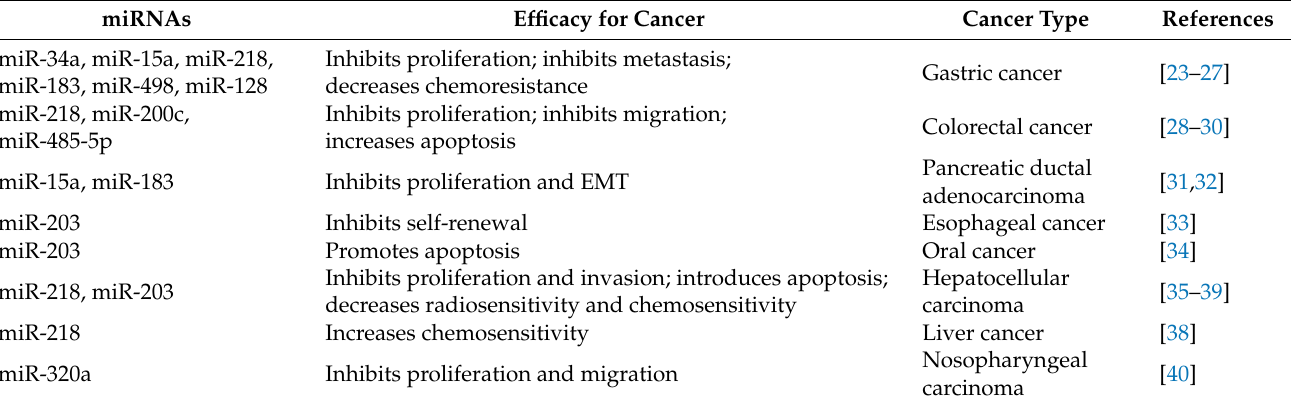
Table 1. MicroRNAs that inhibit Bmi-1 in